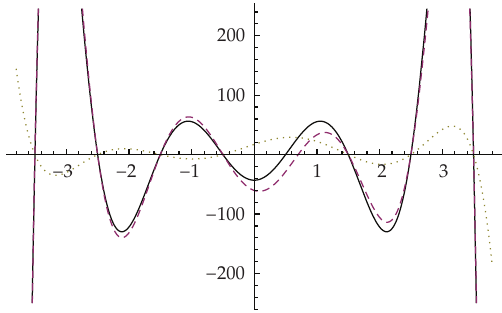
Figure 4: G (cid:3) x (cid:4) (cid:3) solid line (cid:4) , G ε (cid:3) x (cid:4) (cid:3) dashed line (cid:4) , and G (cid:3) x (cid:4) − G ε (cid:3) x (cid:4) (cid:3) dotted line (cid:4)